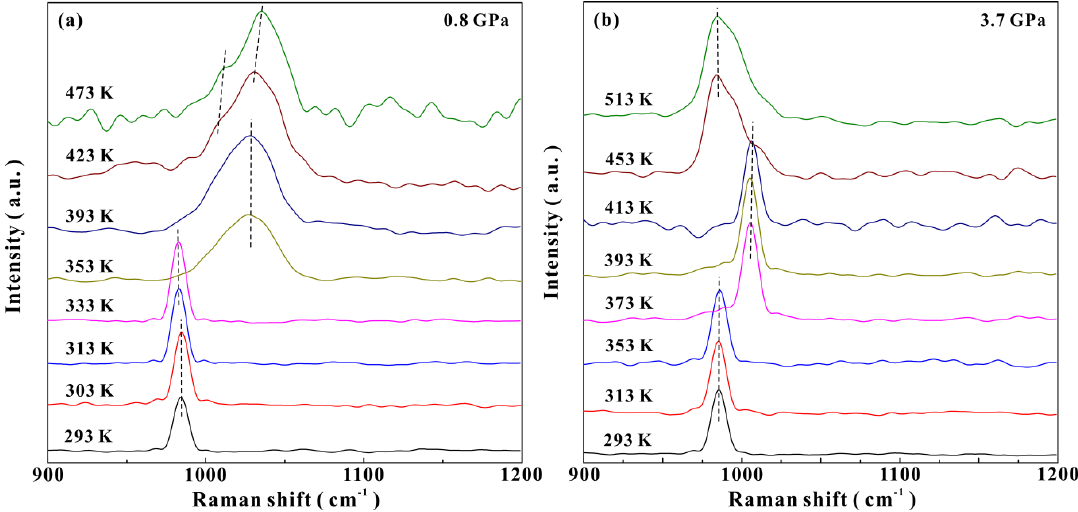
Figure 6. (a) The high ‐ temperature Raman spectra of the epsomite at a pressure of ~0.8 GPa; (b) the Raman spectra of the epsomite with an increasing temperature at ~3.7 GPa.